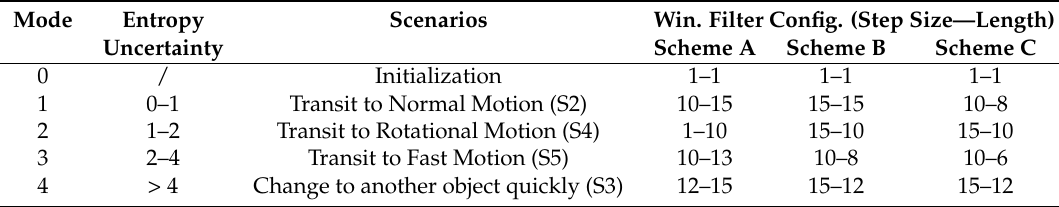
Table 6. Entropy uncertainty score look-up